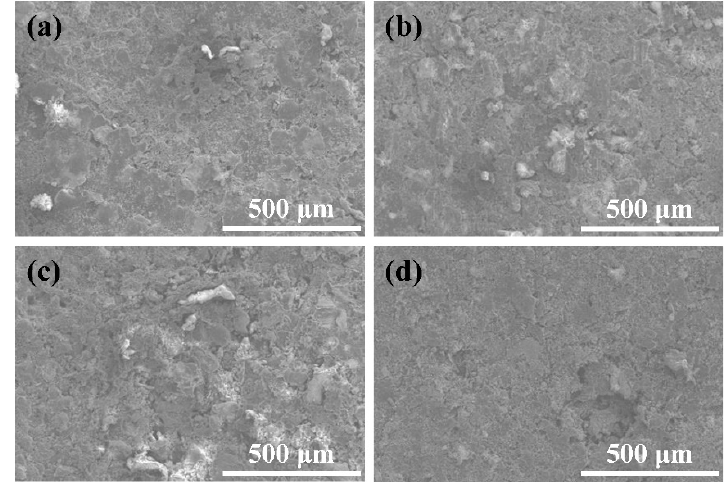
Figure 10. Abrasion morphology of the CSC-coating with ( a ) 0.01 g, ( b ) 0.02 g, ( c ) 0.03 g, and ( d ) 0.04 g CNF contents.